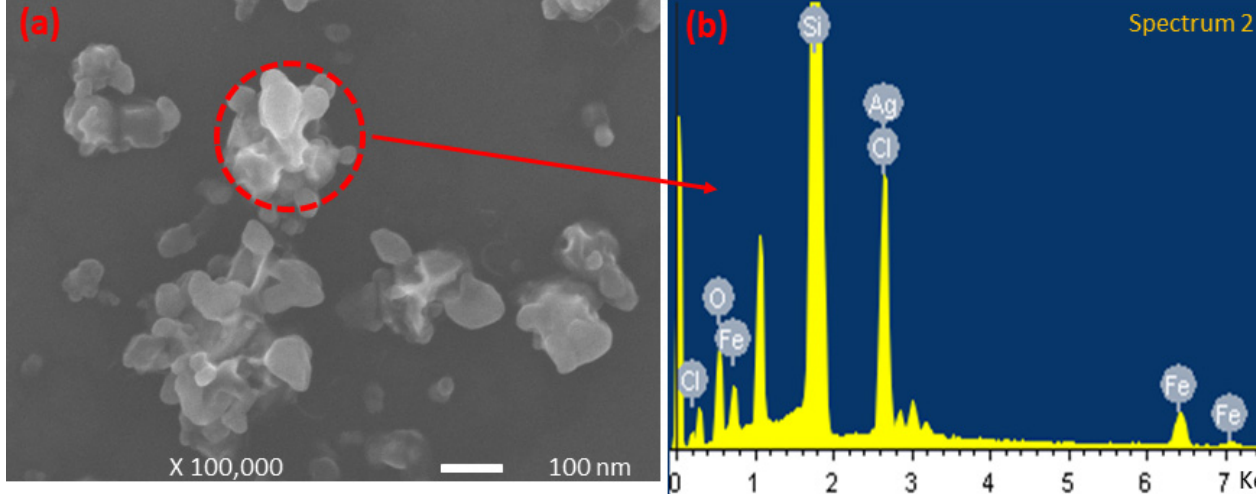
Figure 10. ( a ) SEM image of silver nanocomposite’s aggregate after the addition of Fe 3+ ions; and ( b ) corresponding EDS analysis of aggregate.